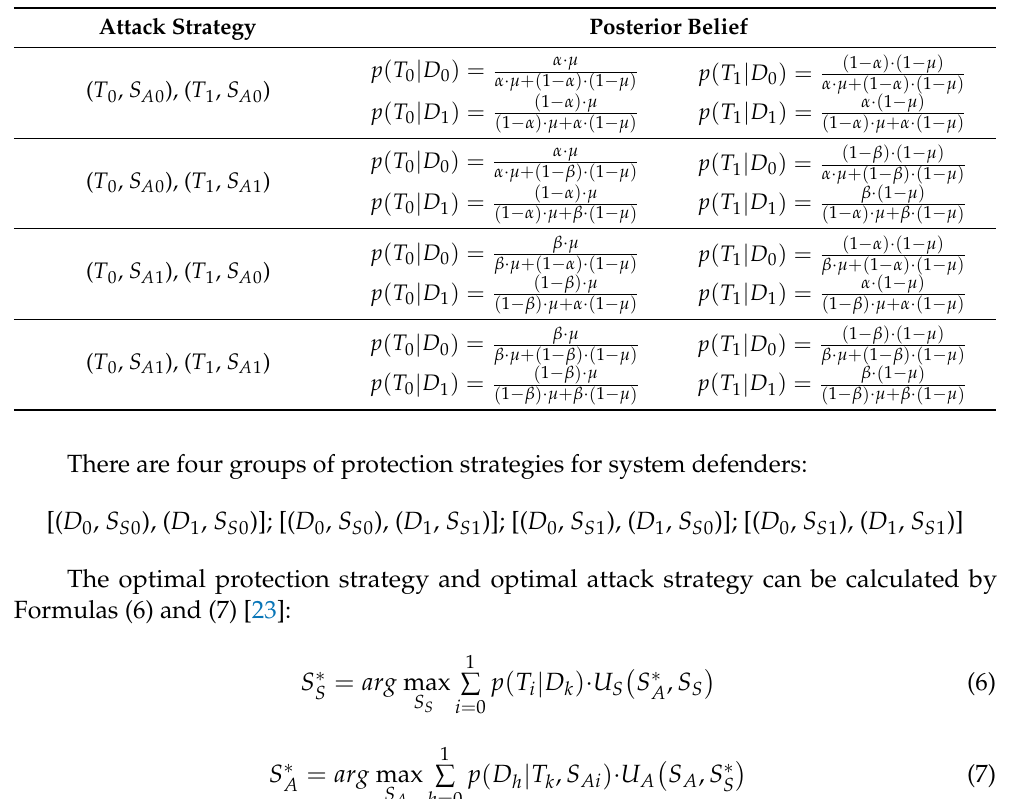
Table 1. The Posterior Beliefs of Defenders under Different Attack